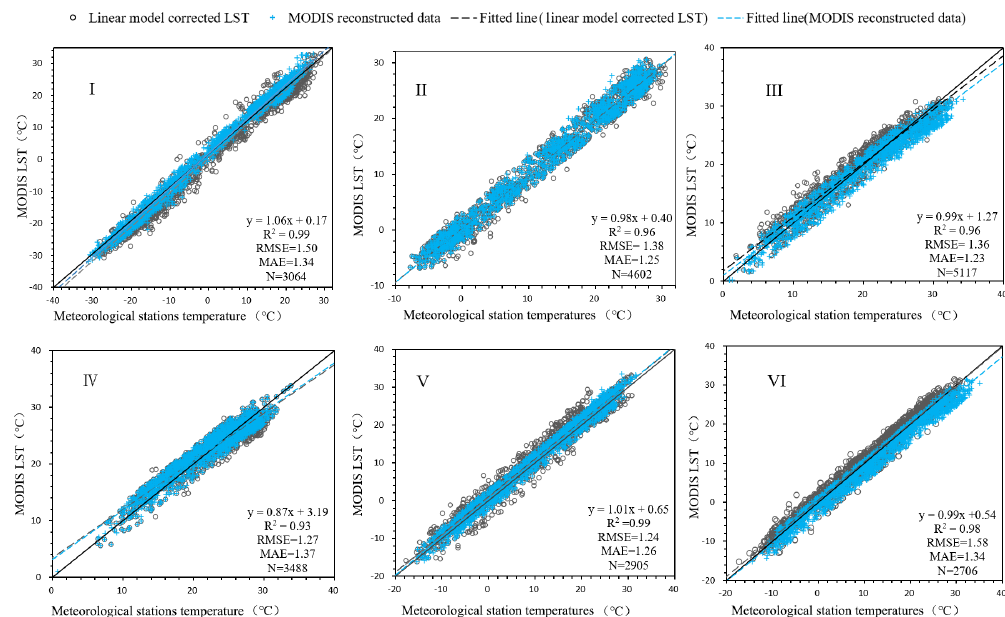
Figure 7. The scatter diagrams in six natural subregions (I, II, III, IV, V and VI) between the ground station data and the monthly MODIS LST data. The blue points represent the verification results of the reconstructed MODIS LST, and the statistical accuracy measures ( R 2 , RMSE and MAE) are also indicated. The results of the corrected linear model are indicated in